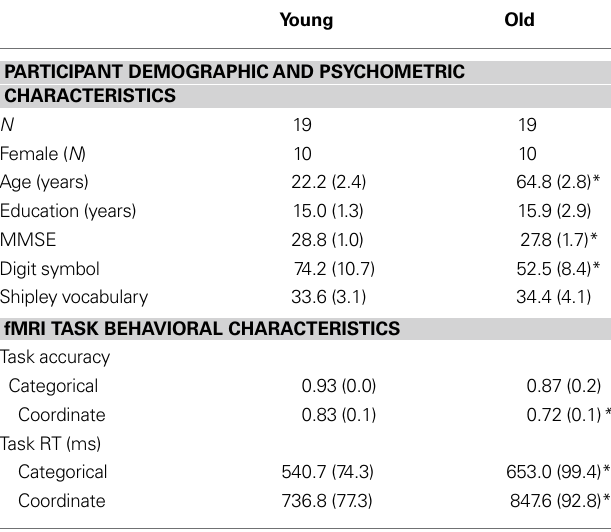
Table 1 | Participant